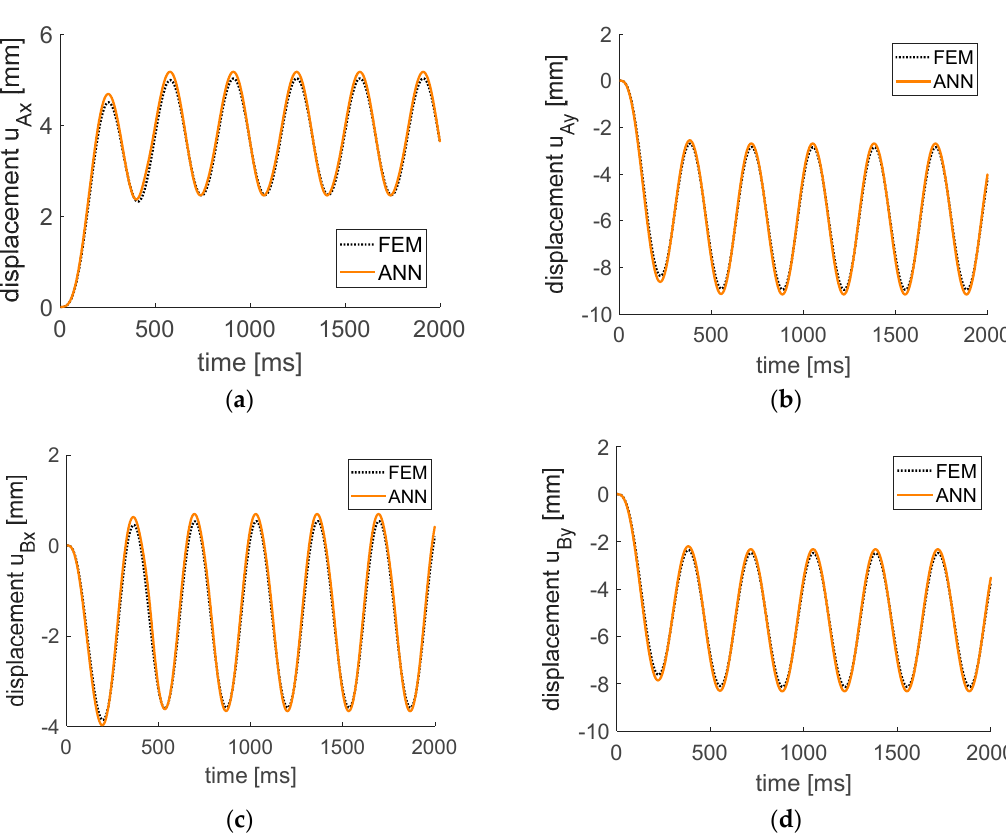
Figure 15. Time course of displacements for shock absorber function (13): ( a ) horizontal displacement of point A, ( b ) vertical displacement of point A, ( c ) horizontal displacement of point B, ( d ) vertical displacement of point B.